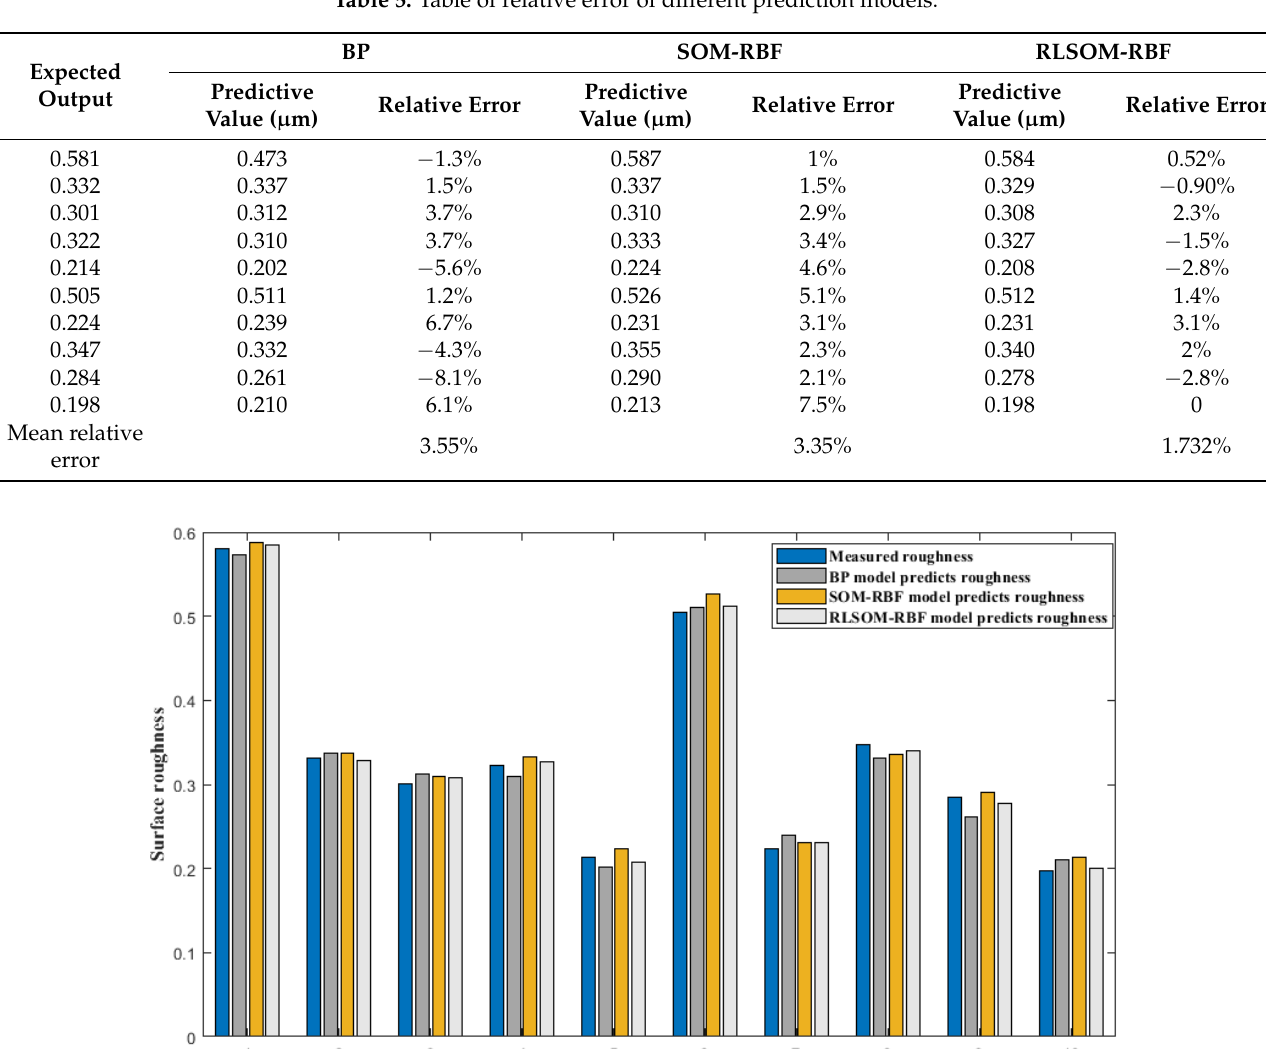
Table 5. Table of relative error of different prediction models.